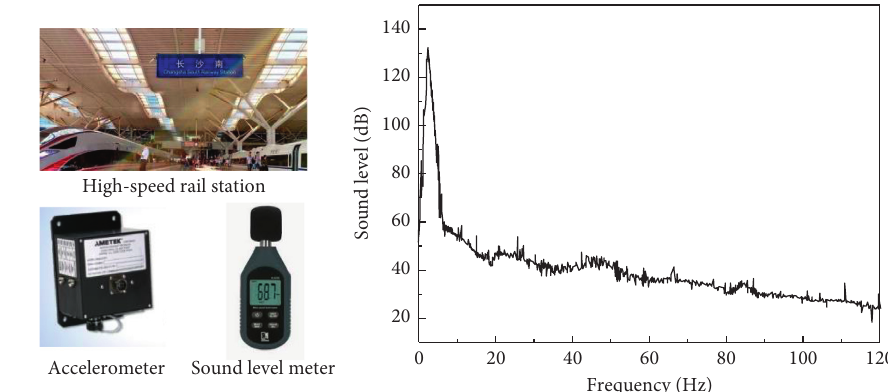
Figure 10: Building vibration signal at a high-speed rail station